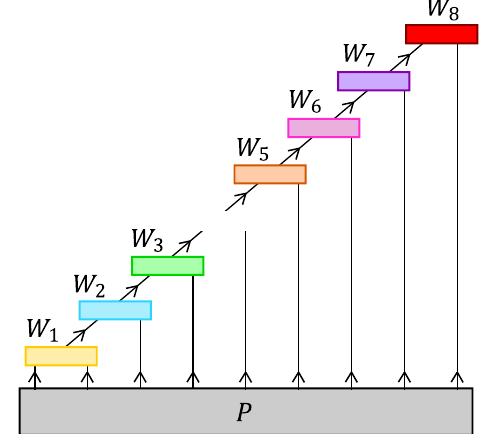
FIG. 11. Example of an environment tensor. Shown here is a possible environment tensor obtained from Fig. 10 by removing tensor W 4 and contracting all remaining tensors, for example, using the MATLAB function ncon() (see Sec. II A 2).